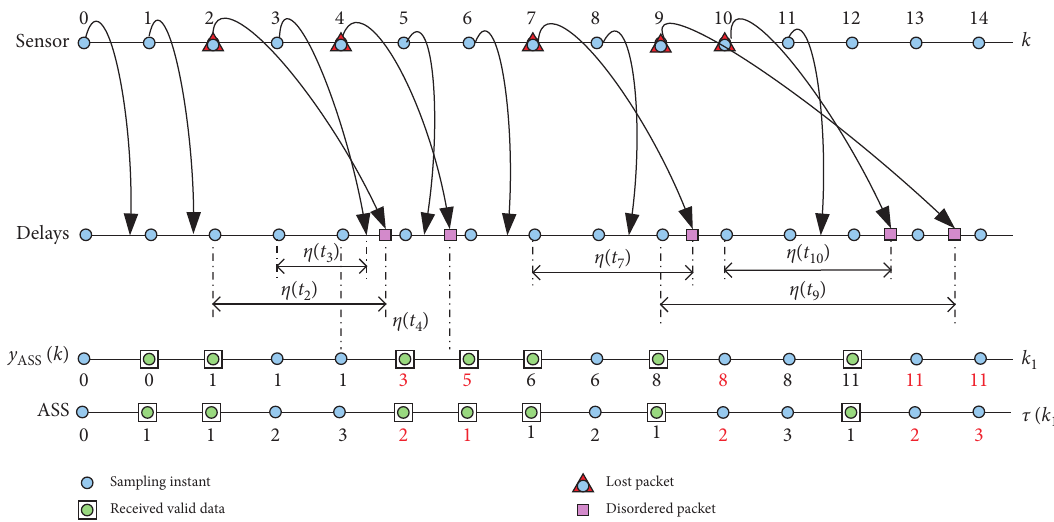
Figure 3: Process of packet sequence resorting using the